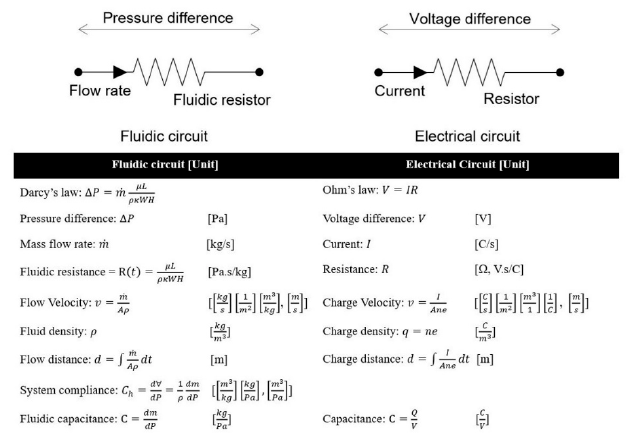
Figure 1. The equivalent circuit comparison between electrical circuit and fluidic circuit and parameter equivalence table including unit analysis.